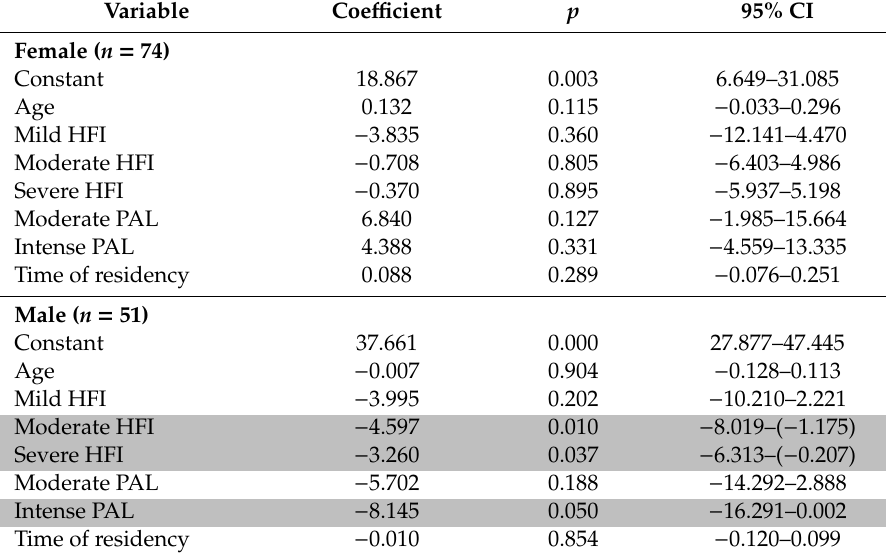
Table 5. E ff ect of HFI, physical activity, age, and time of residency on body mass index (BMI) of male and female farm workers from Northwest